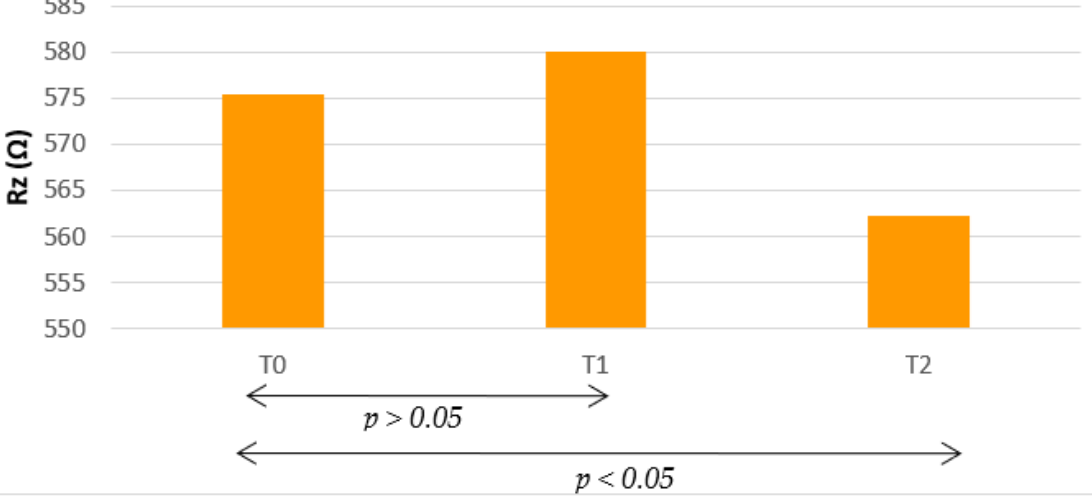
Figure 2. After exposure to ion-cyclotron emission, average resistance statistically significantly decreases at T2 in selected acupuncture points.